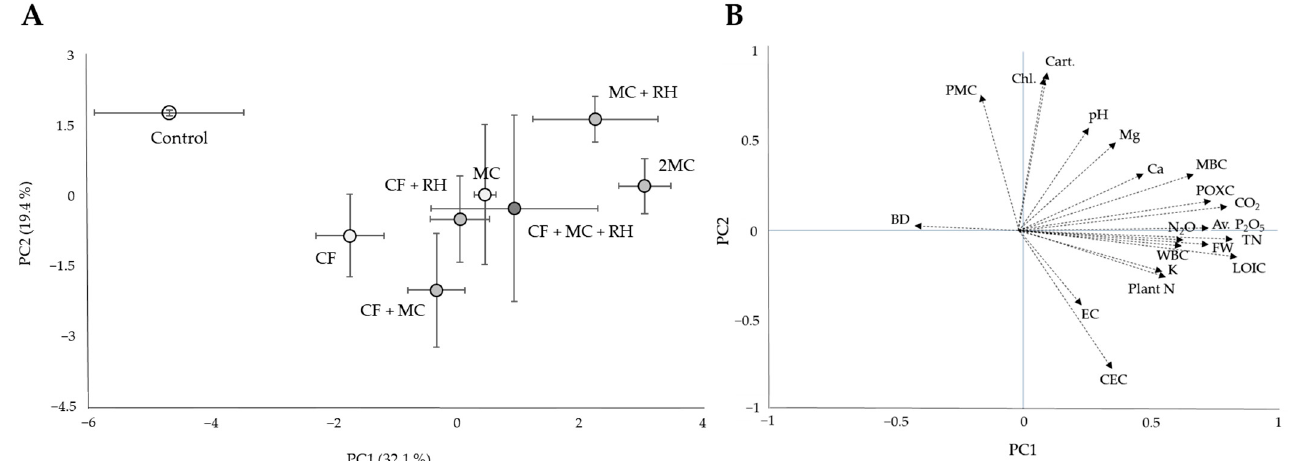
Figure 4. PCA of the biogeochemical properties of soils with different fertilizer treatments. ( A ) Component scores (mean ± standard deviation) for first two principal components of fertilizer treatments. ( B ) Loading plot of soil and plant parameters.